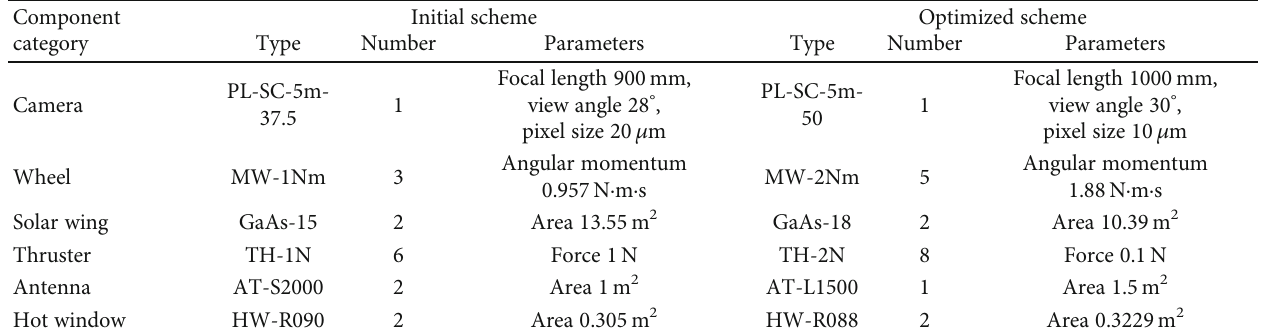
Table 4: Optimization results of key components in the tree structure.